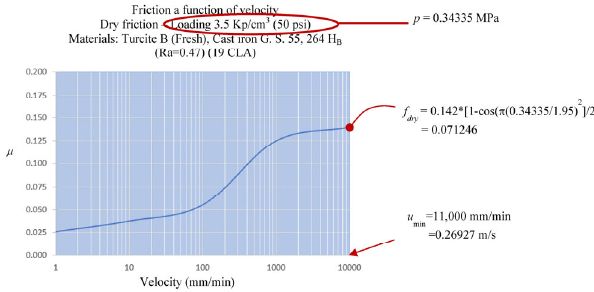
Fig. 16 COF under dry friction condition for PTFE [13].